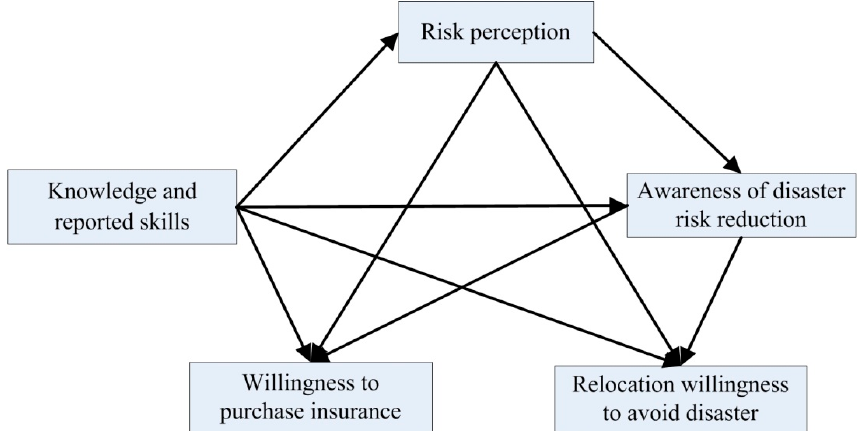
Figure 1. Theoretical framework of the disaster risk perception model.